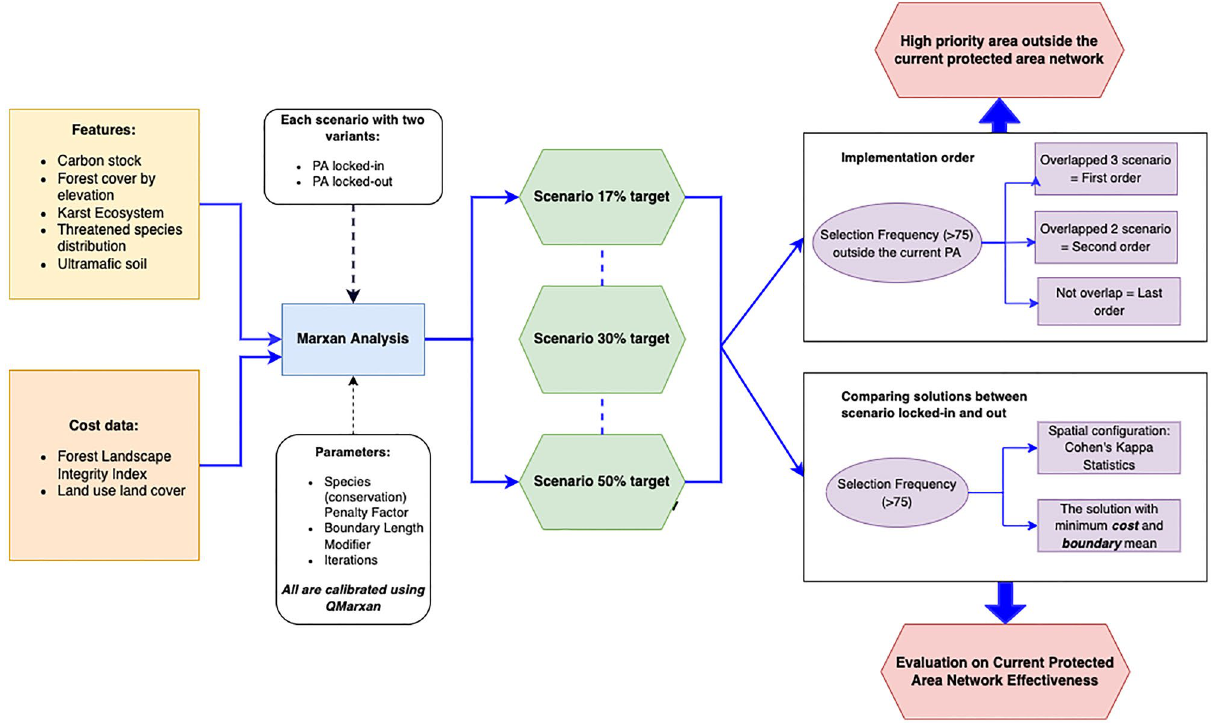
Figure 1. Workflow for identifying priority conservation areas in Sulawesi under three protection